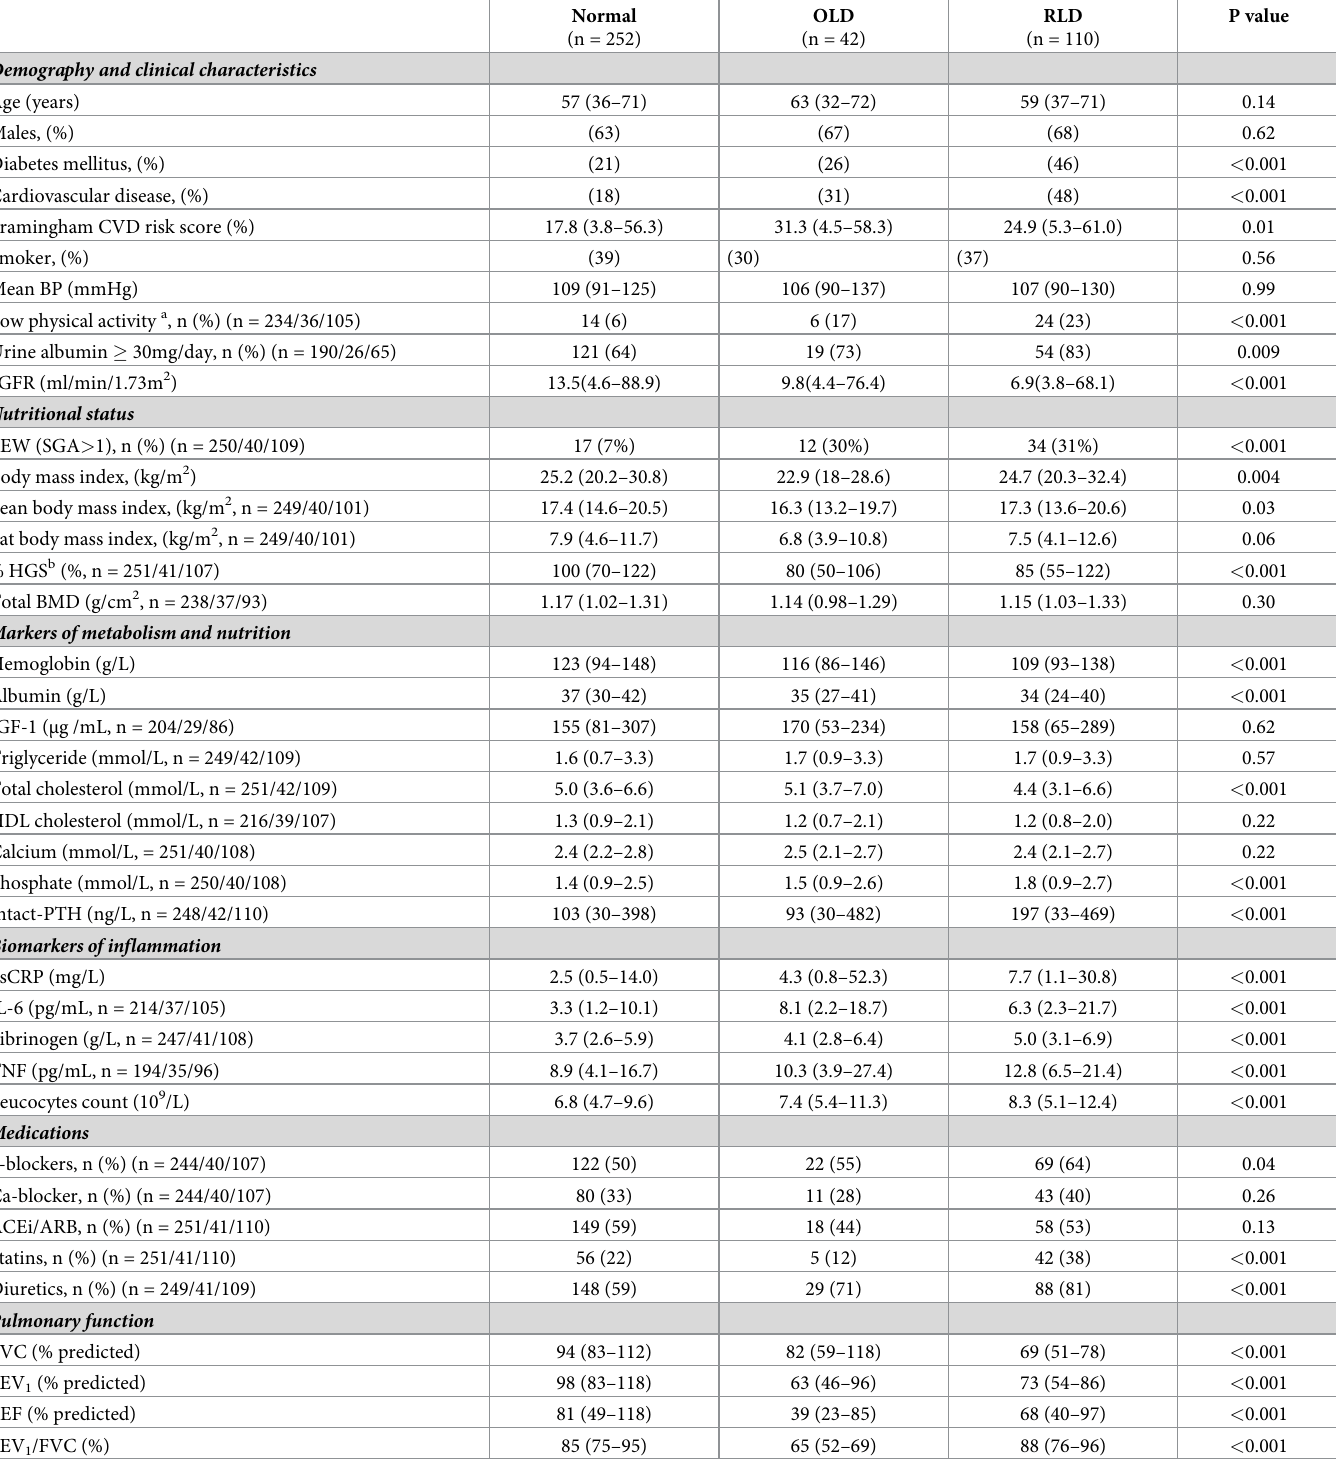
Table 1. Clinical and biochemical characteristics of 404 individuals with various degrees of impairment of renal function divided according to spirometry results indicating normal lung function, obstructive lung disorder (OLD) or restrictive lung disorder